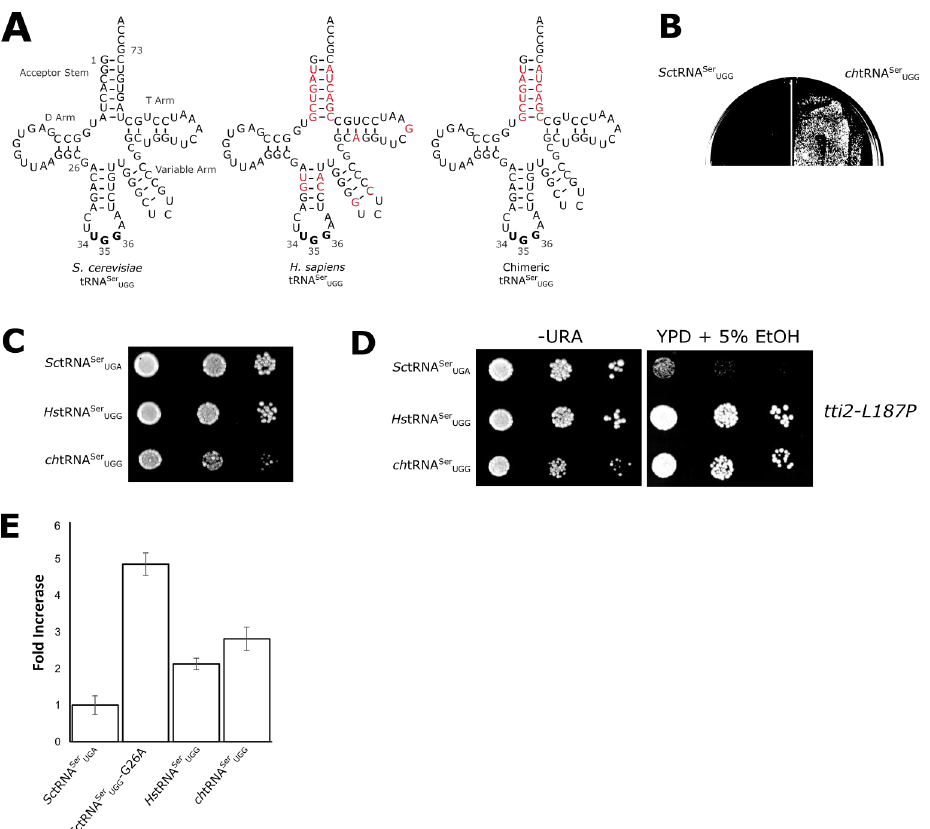
Figure 2. The human tRNA Ser acceptor stem decreases the functionality of yeast tRNA Ser . ( A ) Secondary structures of tRNA SerUGG derivatives used in these studies. The chimeric molecule contains the human acceptor stem on the yeast tRNA. Differences with the S. cerevisiae tRNA SerUGG ( SUP17 UGG ) are in red. ( B ) URA3 centromeric plasmids expressing the chimeric tRNA ( ch tRNA SerUGG ) with a UGG anticodon or Sc tRNA Ser ( SUP17 ) with a UGG anticodon were transformed into BY4742 and grown at 30 °C for 2 days on a minimal plate. ( C ) BY4742 expressing Sc tRNA SerUGA , Hs tRNA SerUGG , or ch tRNA SerUGG were grown overnight in minimal media, serially diluted, plated on media lacking uracil, and grown at 30 °C for 2 days. ( D ) Plasmids expressing Sc tRNA SerUGA , Hs tRNA SerUGG , or ch tRNA SerUGG were transformed into the tti2-L187P strain CY7020, streaked for individual colonies, grown in minimal medium for 40 h, 10-fold serially diluted, spotted on minimal plates lacking uracil (-URA) or yeast peptone dextrose (YPD) containing 5% ethanol, and grown at 30 °C for 2 days (for - URA) or 3 days (for YPD + 5% ethanol). ( E ) A reporter plasmid containing GFP expressed from a Hsf1- activated promoter was transformed into BY4742 also containing centromeric plasmids expressing wild-type Sct RNA SerUGA , Hs tRNA SerUGG , or ch tRNA SerUGG . Starter cultures were grown in minimal medium, diluted into fresh selective medium, and grown for eight hours. Induction of the Hsf1-GFP was measured by fluorescence at 528 nm. Numbers shown are the average of five biological replicates performed in duplicate with the standard deviation shown.